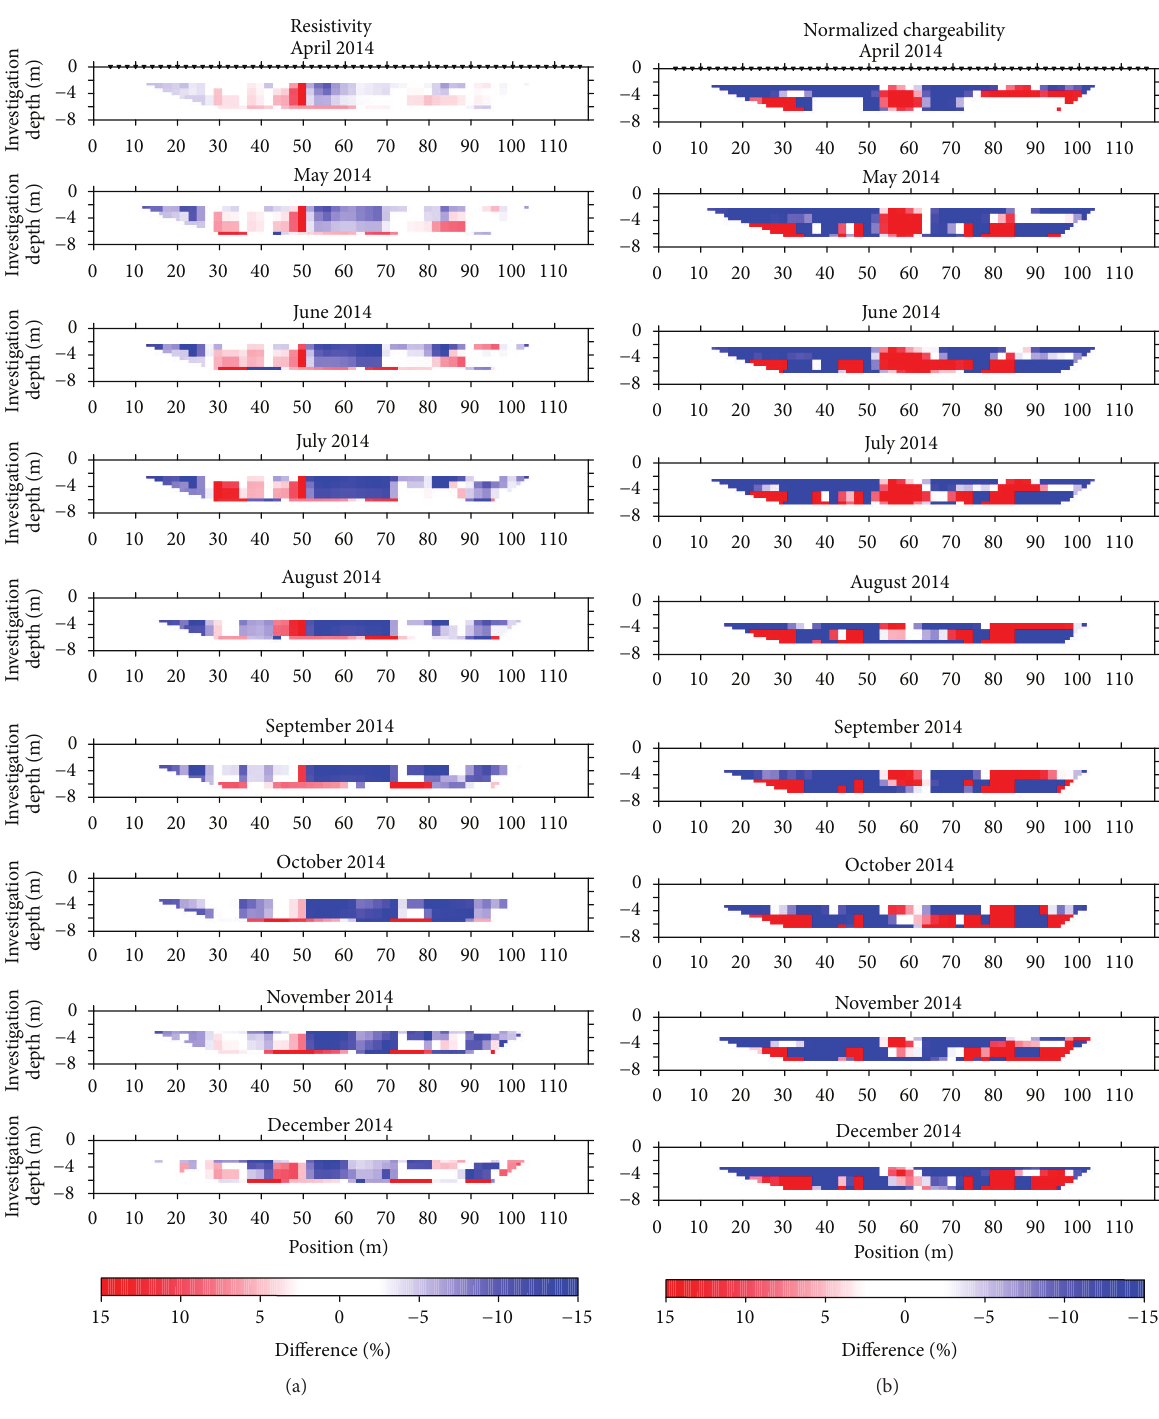
Figure 8: Percentage difference ( 𝑃 ) over March 2014 of resistivity 𝜌 (a) and normalized chargeability 𝑛𝑚 (b) sections, for the permanent electrical profile, with 𝑃 𝜌 = (𝜌 𝑡𝑖 − 𝜌 𝑡0 )/𝜌 𝑡0 ∗ 100 and 𝑃 𝑛𝑚 = (𝑛𝑚 𝑡𝑖 − 𝑛𝑚 𝑡0 )/𝑛𝑚 𝑡0 ∗ 100 .